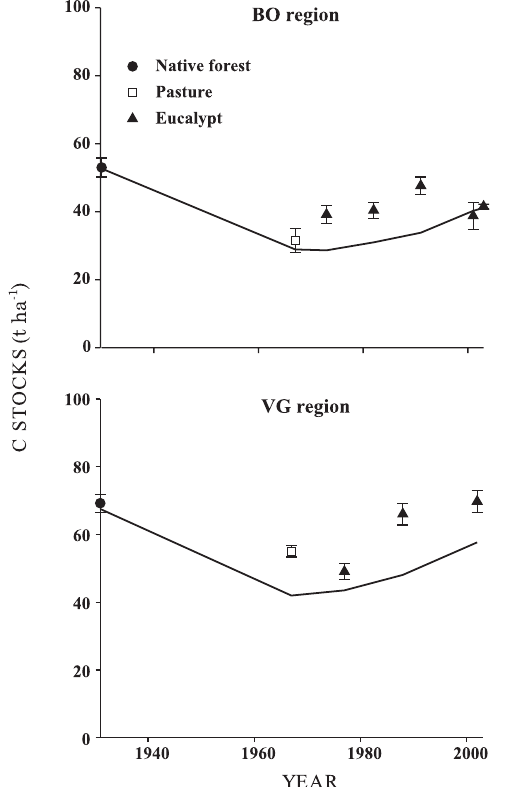
Figure 2. Observed (symbols) and simulated (solid line) SOC stocks by Century for the 0–20 cm soil layer of eucalyptus chronosequences in the regions of Belo Oriente (BO) and Virginópolis